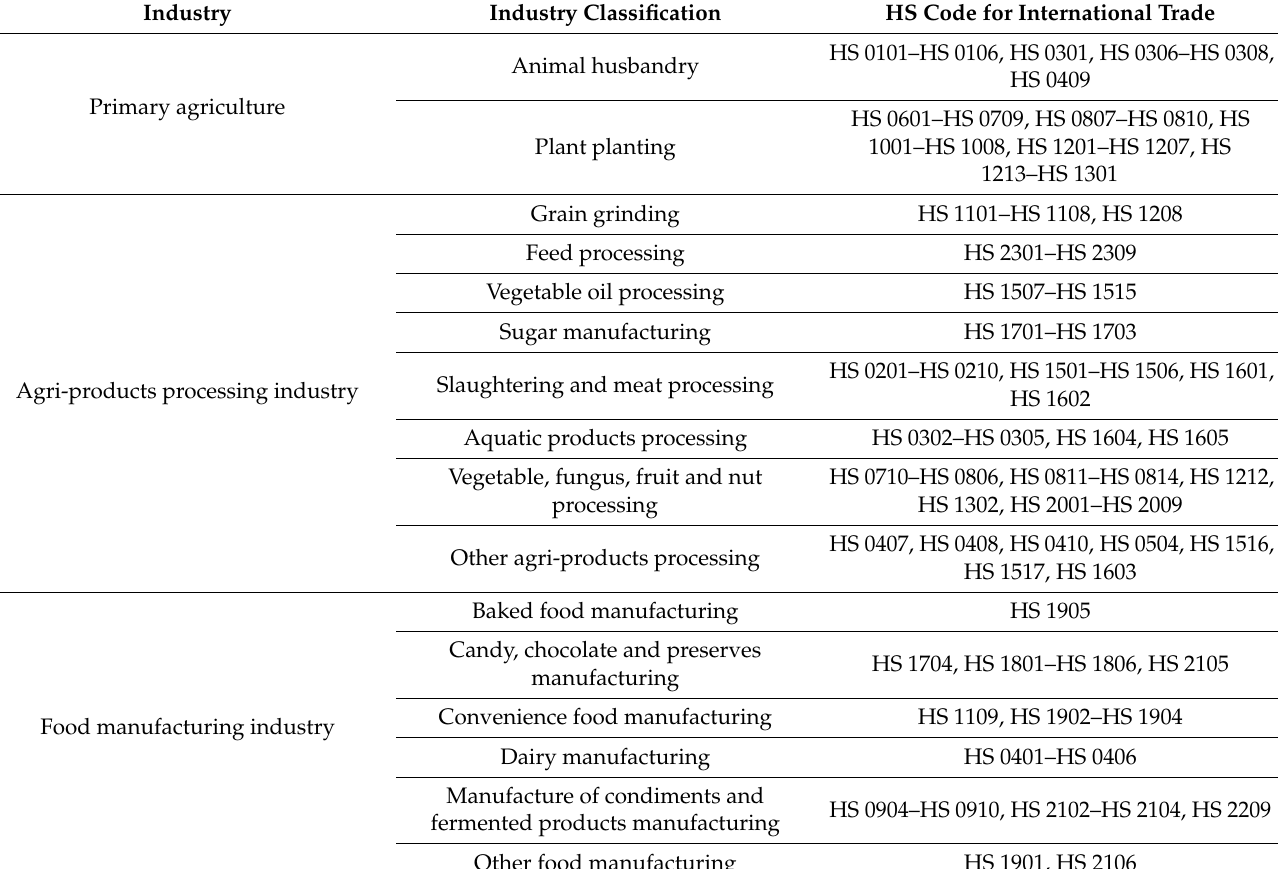
Table A1. Industry classification, product category, and HS